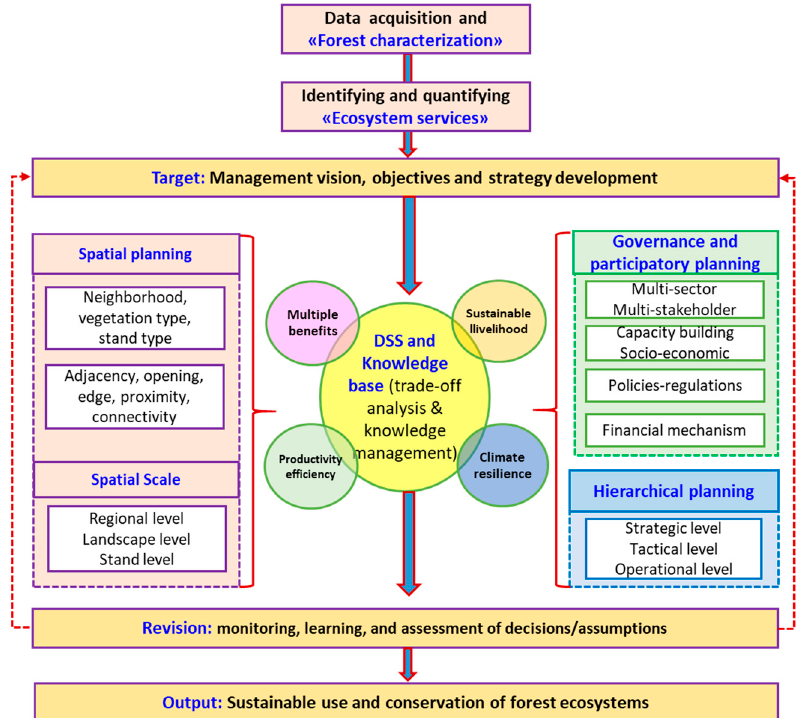
Figure 2. The conceptual framework components indicating the organization and connections to ecosystem planning processes.